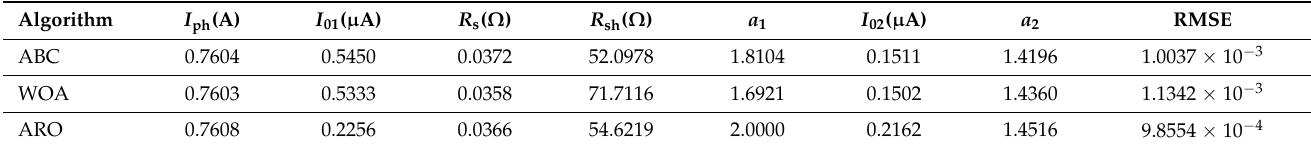
Table 2. Parameter identification results obtained by various algorithms under